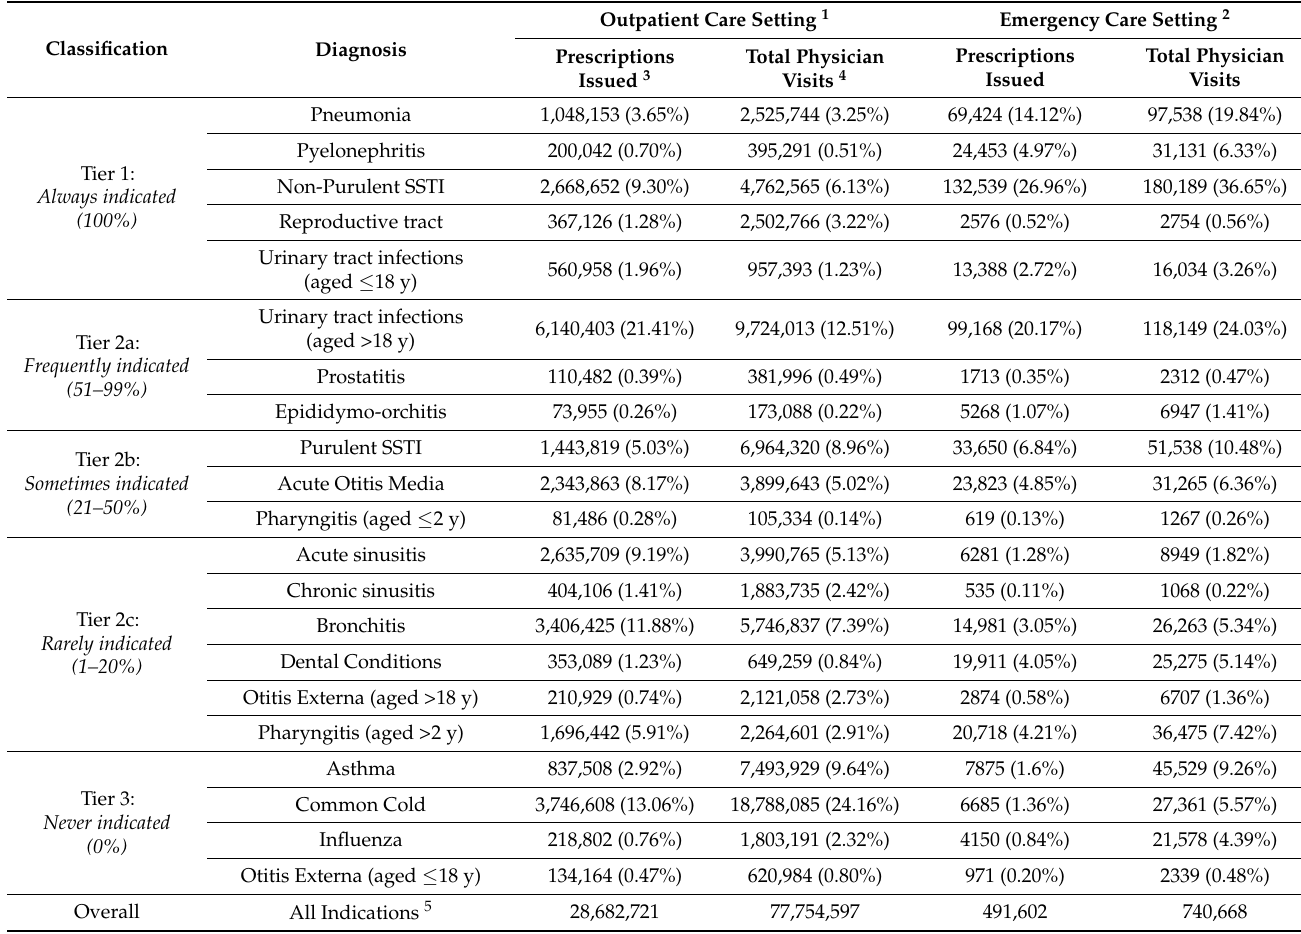
Table 2. Number of total cases and associated antibiotics dispensed per indication of interest, by healthcare setting.